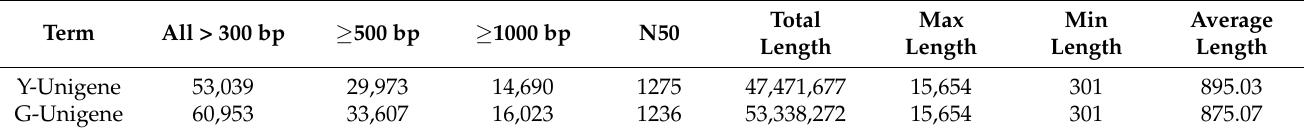
Table 1. Length distribution of assembled unigenes.